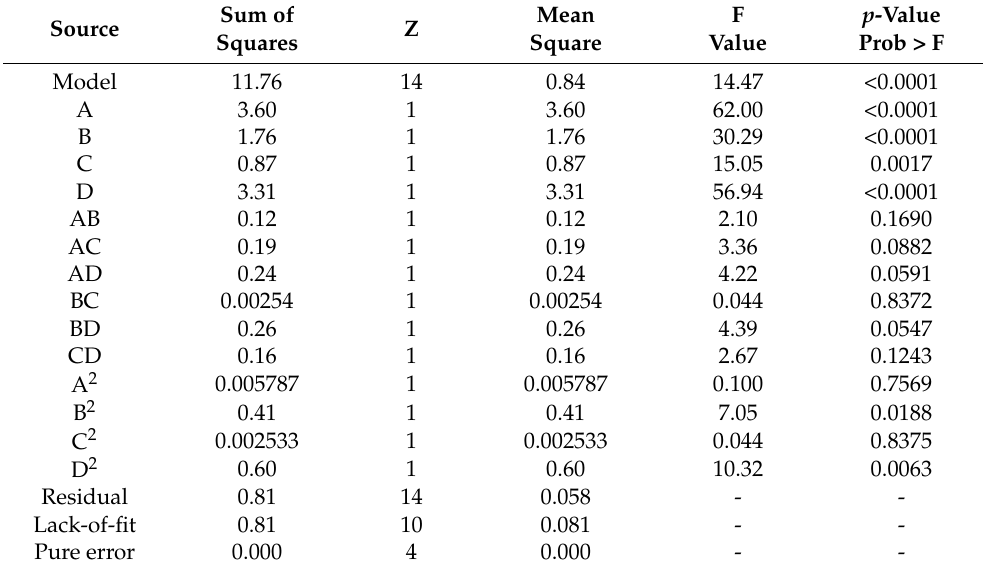
Table 2. Analysis of variance for the